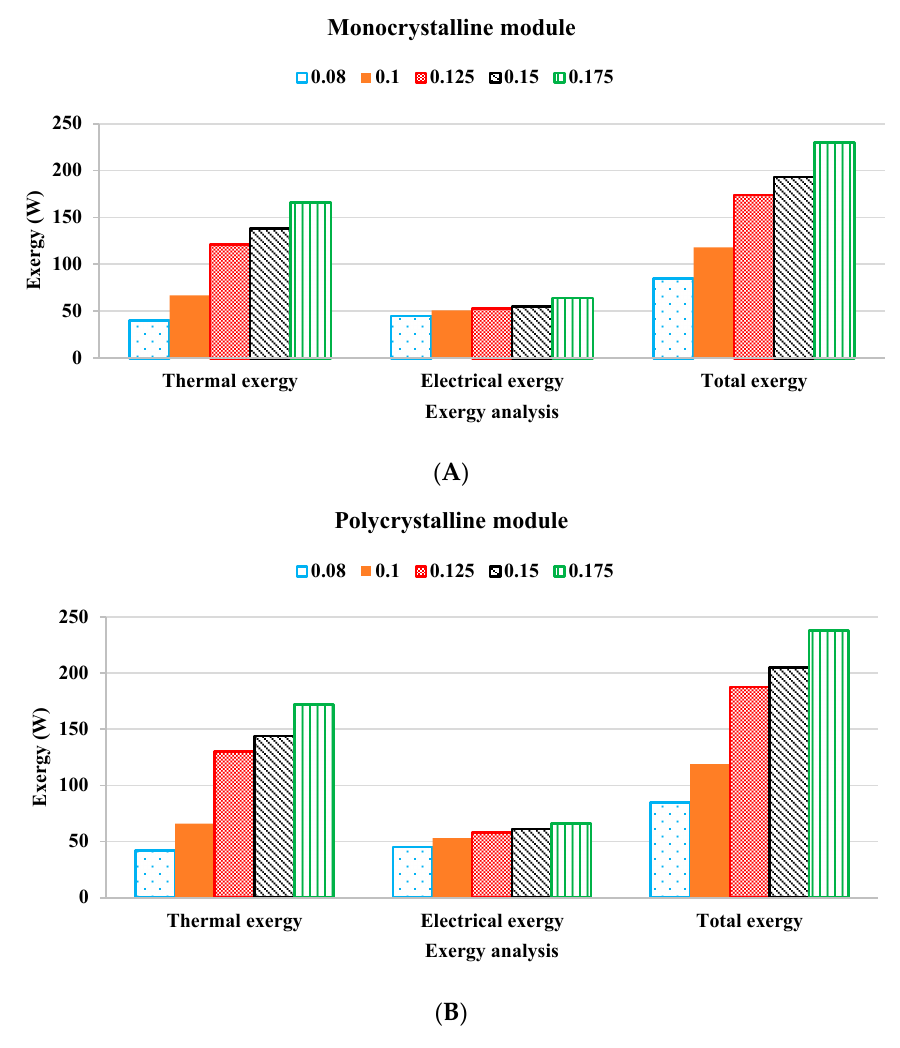
Figure 8. Exergy analysis for both monocrystalline ( A ) and polycrystalline ( B ) PV/T systems. At high mass flowrates, the PV/T thermal exergy remains high, and it is observed to continue to rise up to a certain point, which is consistent with the mathematical models and other studies published on this topic. Increasing the mass flowrate from 0.08 kg/s to 0.175 kg/s led to an increase in the thermal exergy of around 300% (from 42 to 172 W) and 315% (from 40 to 166 W) for the poly- and mono-crystalline PV/T collectors—considering an average exergy input of around 328.65 W/m 2 . Meanwhile, minimal variations were observed for the electrical exergy produced by the PV model, which means this type of sys- tem can be considered to be thermally biased. It is noteworthy to mention that the electri- cal yield of the system is a high-grade form of energy, while the thermal yield is consid- ered to be low-grade. Table 7 lists the results of some valuable studies in the literature and